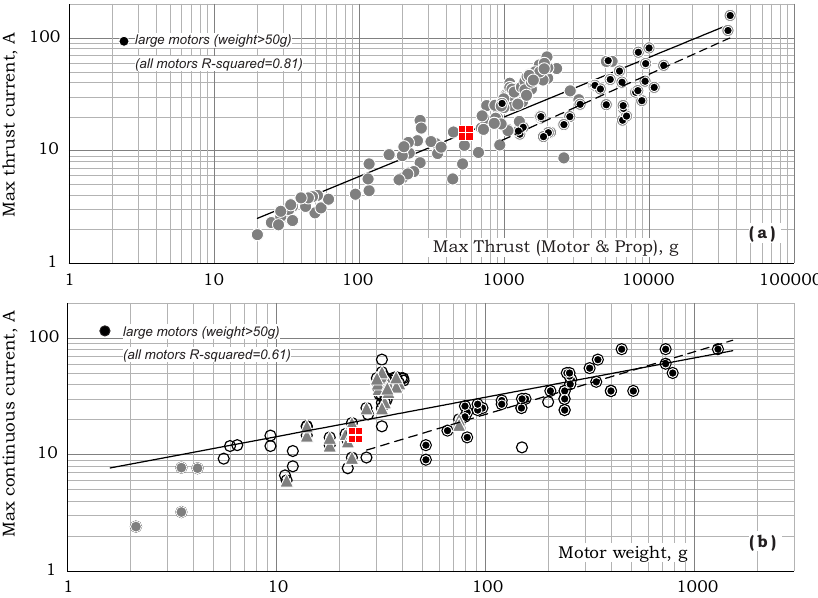
Figure 7. Motor current consumption design trends, [17,18]. Full line: all motors; Dashed line: large motors (weight >